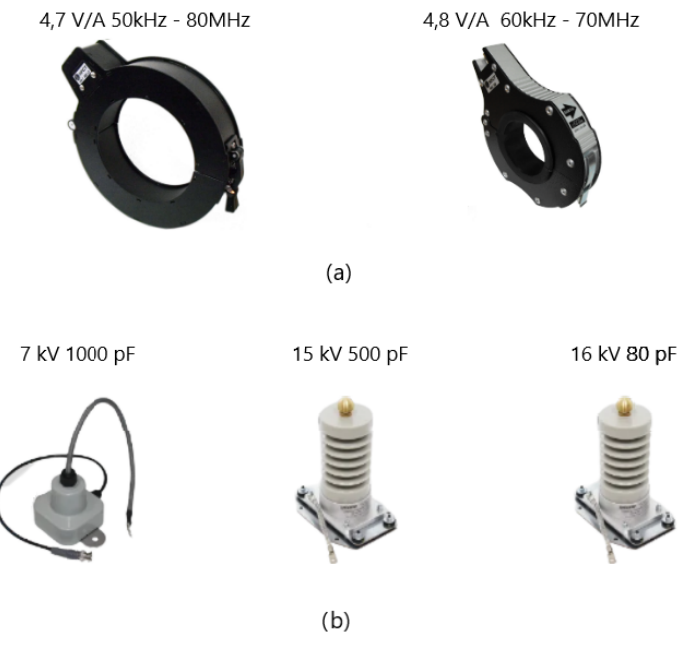
Figure 18. Photograph of some ( a ) HFCTs [46] and ( b ) coupling capacitors [47] used for PD